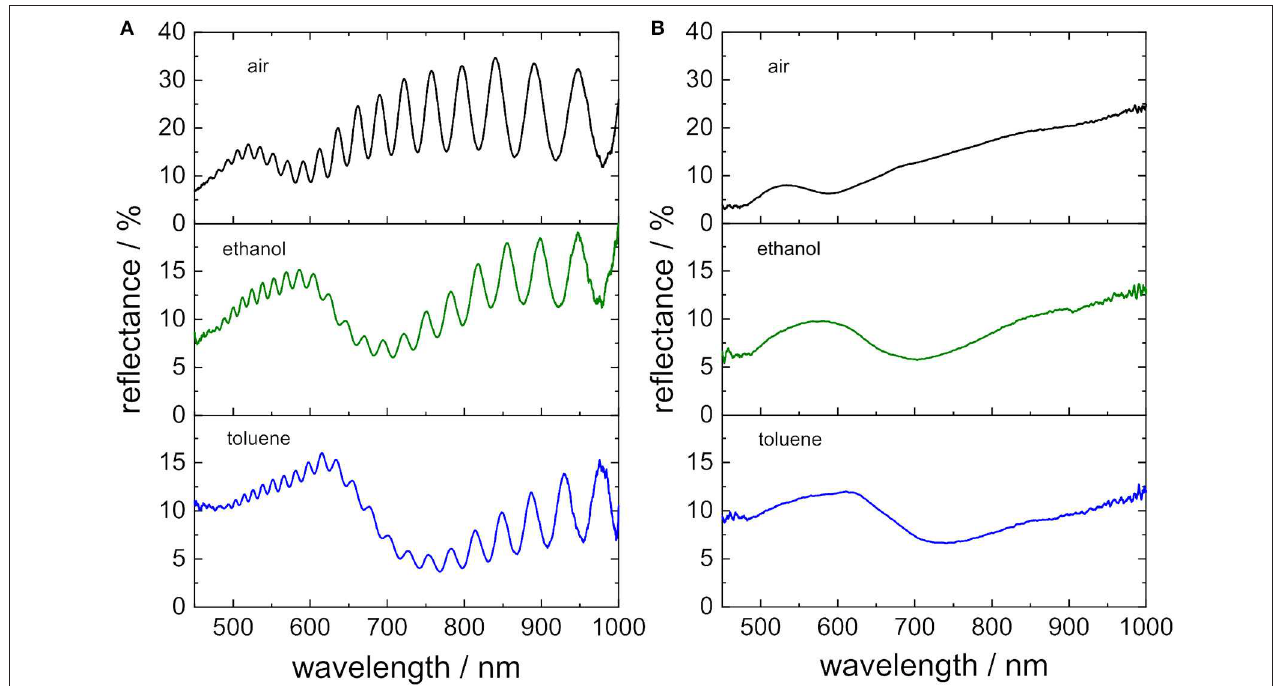
FIGURE 3 | Optical characterization of sensors composed of porous silicon/gold nanostructures and gold nanostructures on silicon. (A) Reflectance spectra of porous silicon/gold nanostructures immersed in different dielectric media. (B) Corresponding reflectance spectra of isolated gold nanostructures on